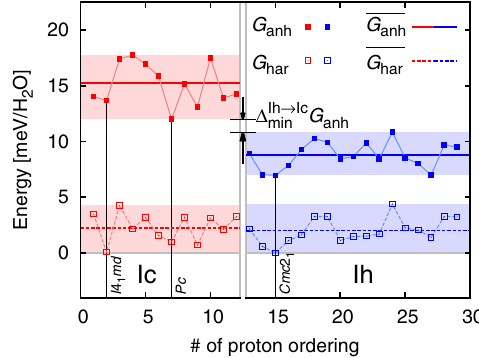
FIG. 2. Harmonic ( G , empty squares, lower part) and har anharmonic ( G , filled squares, upper part) energies including anh zero-point nuclear motion for different Ih (blue) and Ic (red) proton orderings (Supplemental Table I [19]). The averages over proton orderings G and G are shown as thick horizontal har anh dotted and solid lines, respectively. All energies are measured with respect to G XIh (Ih Cmc 2 1 , structure har